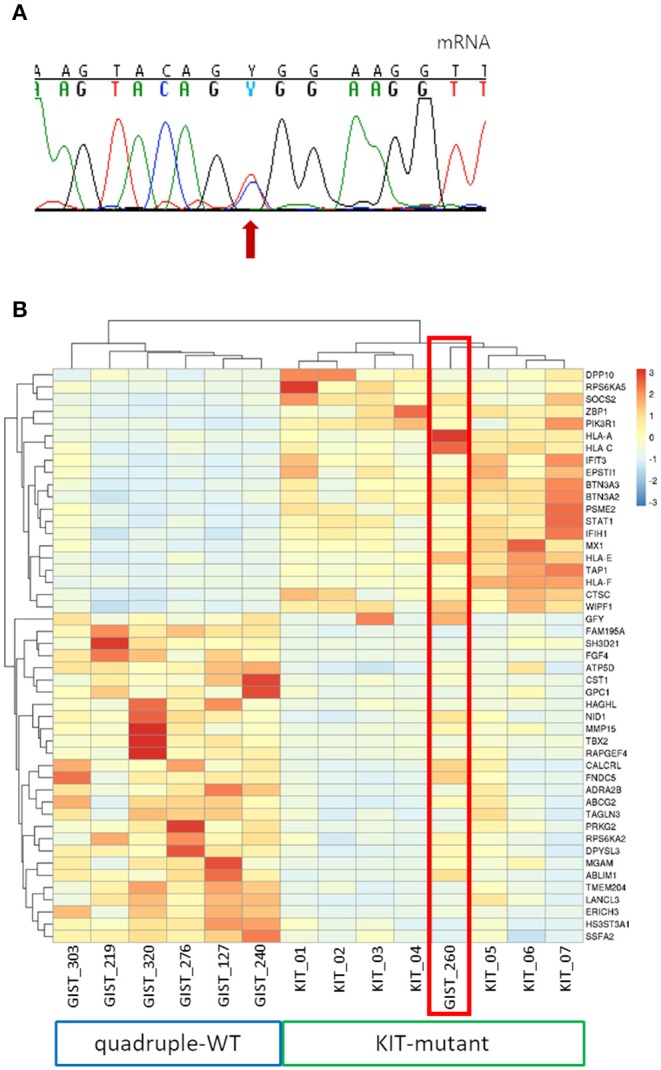
Analysis of KIT-specific gene expression in GIST_260. (A) Mutant allele expression in GIST_260 mRNA. Despite the low-allele-fraction in DNA, the mutant allele is highly expressed. (B) Hierarchical clustering of the top genes differentially expressed between the seven KIT-mutant cases and the six quadruple-WT (p < 10−3). GIST_260 clusters with KIT-mutant samples.